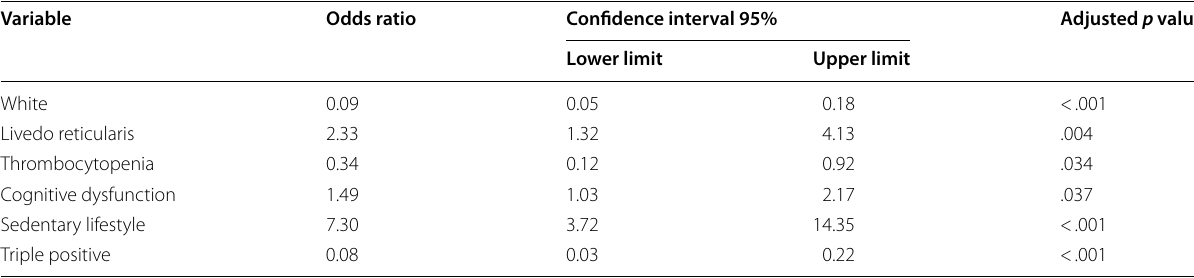
Table 2 Results of the multivariate analysis of BPAPS versus non‑BPAPS patients Variable Odds ratio